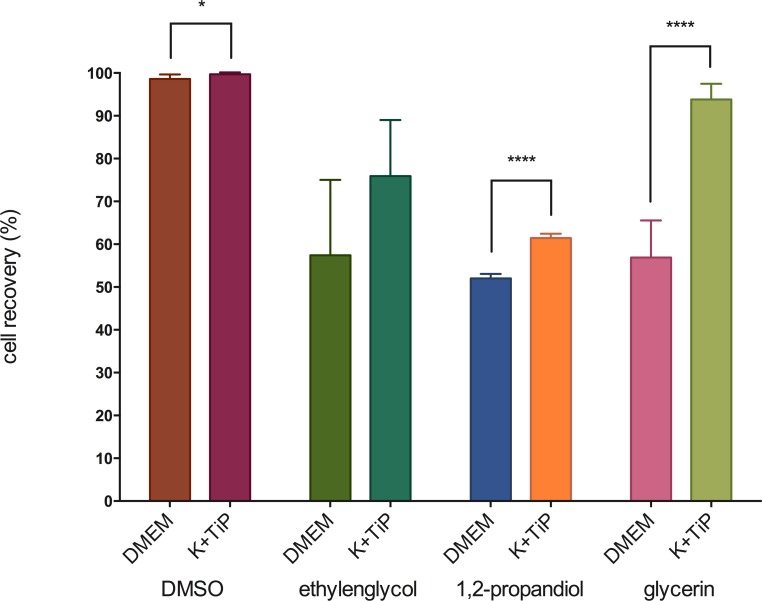
Cell recovery by using vitrification.Figure 4 illustrates cell recovery of vitrified MHEC-5Ts immediately after thawing. DMEM = DMEM Ham’s F-12 Gln+, 20% FBS, and 3M of one of the CPAs; K+TiP = K+TiP. 0.5M sucrose, 20% FBS, and 3M of one of the CPAs; * = significant (p < 0.05); **** = highest siginificance (p < 0.0001).